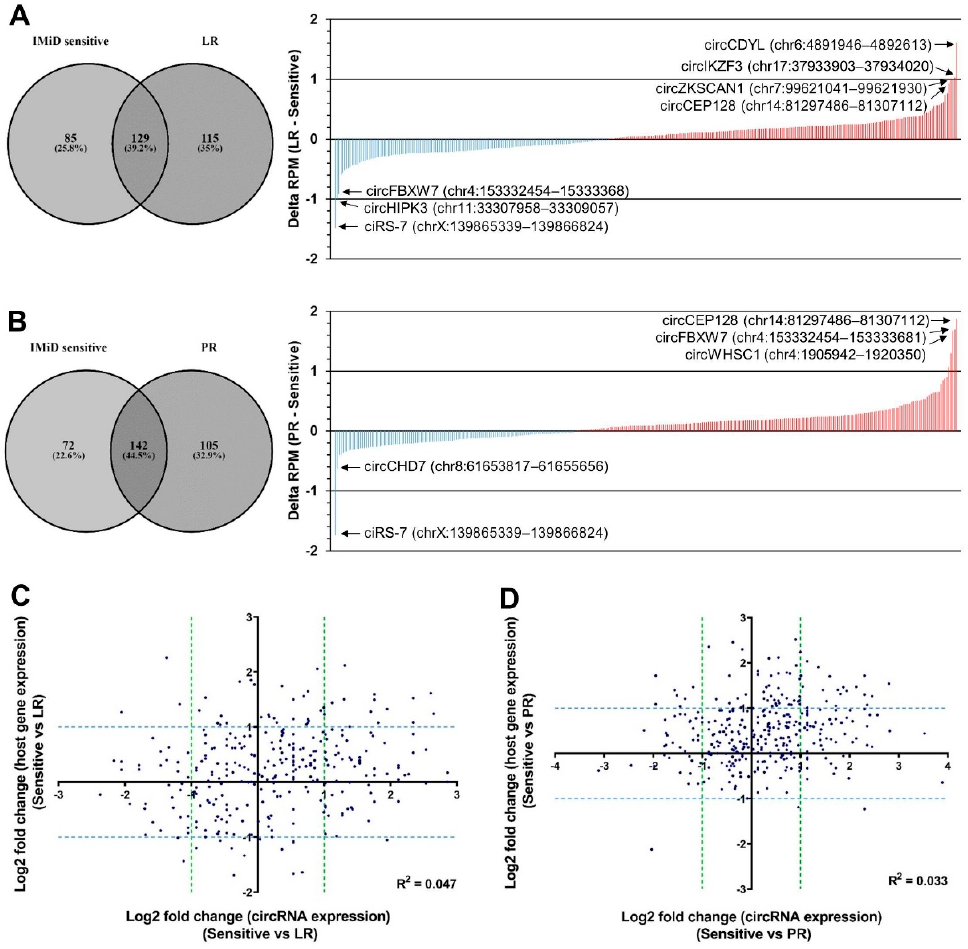
Figure 2. Changes in circRNA expression upon acquired resistance to IMiDs. ( A , B ) Waterfall plots illustrating the upregulated (in red) and downregulated circRNAs (in blue) in LR cells ( A ) and PR cells ( B ) relative to parental (IMiD-sensitive) cells. CircRNAs defined as high abundance in either parental cells, LR cells or PR cells, as shown in the Venn diagrams (left), were included in the analysis. ( C , D ) Scatter plots of log2 fold change in circRNA expression and log2 fold change in host gene expression in LR ( C ) and PR ( D ) cells compared to parental (sensitive) cells. Potential correlations were assessed by calculating Pearson correlation coefficients, R 2 . LR, lenalidomide ‐ resistant, PR, pomalidomide ‐ resistant.